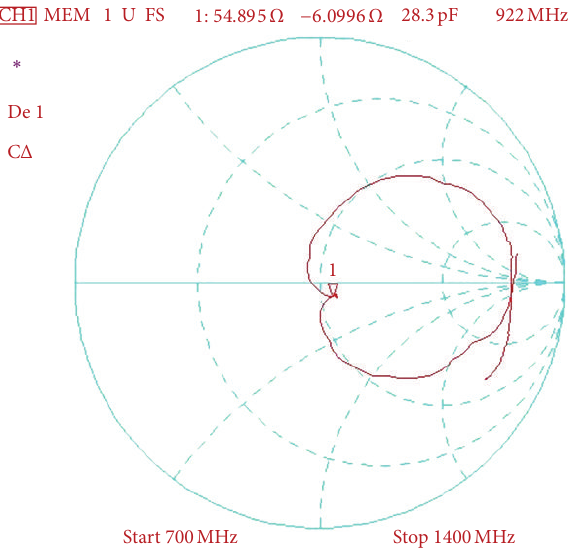
Figure 6: AR of the designed RFID antenna versus